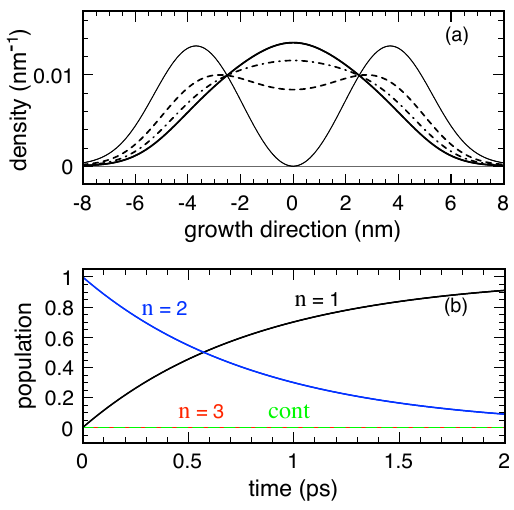
Figure 12. The same as in Figure 6 but replacing the local Boltzmann model in Equation (10) with the proposed nonlocal model in Equation (37). Reprinted from